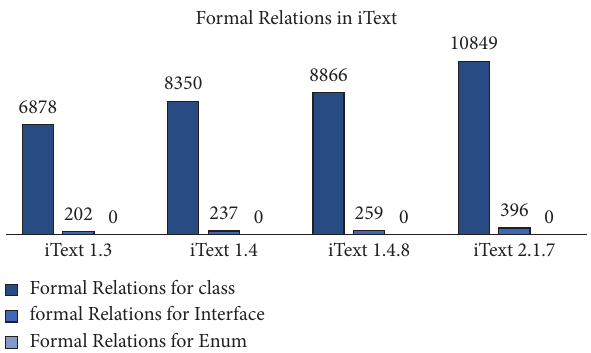
Figure 4: Count of formal relationships in